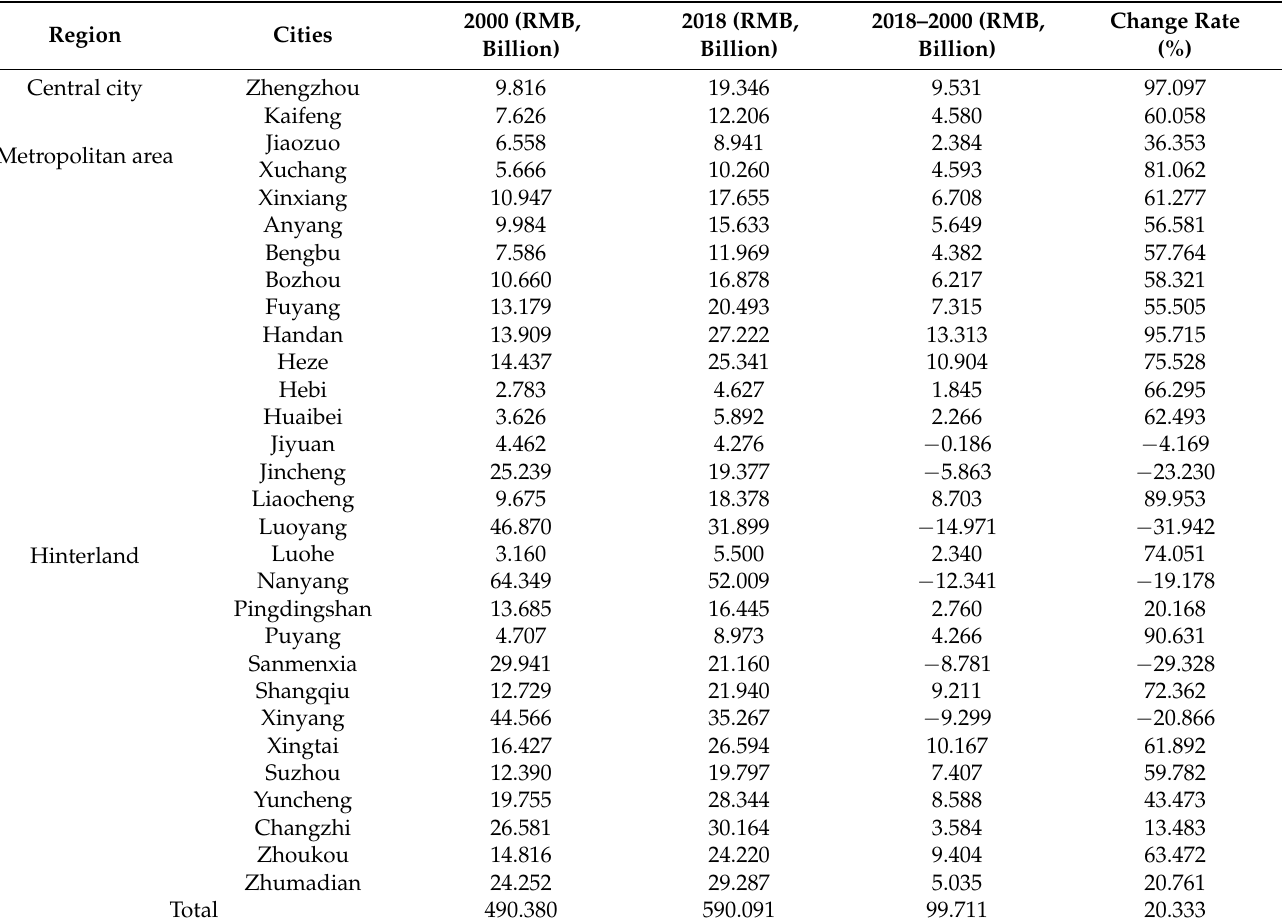
Table 4. The ESV amount and change rate of cities in the Central Plains Urban